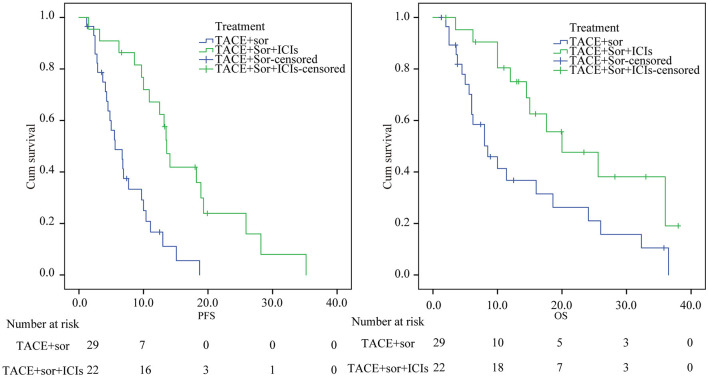
Kaplan–Meier analysis of PFS and OS. TACE, transarterial chemoembolization; Sor, sorafenib; ICIs, immune checkpoint inhibitors; PFS, Progression-free survival; OS, overall survival.